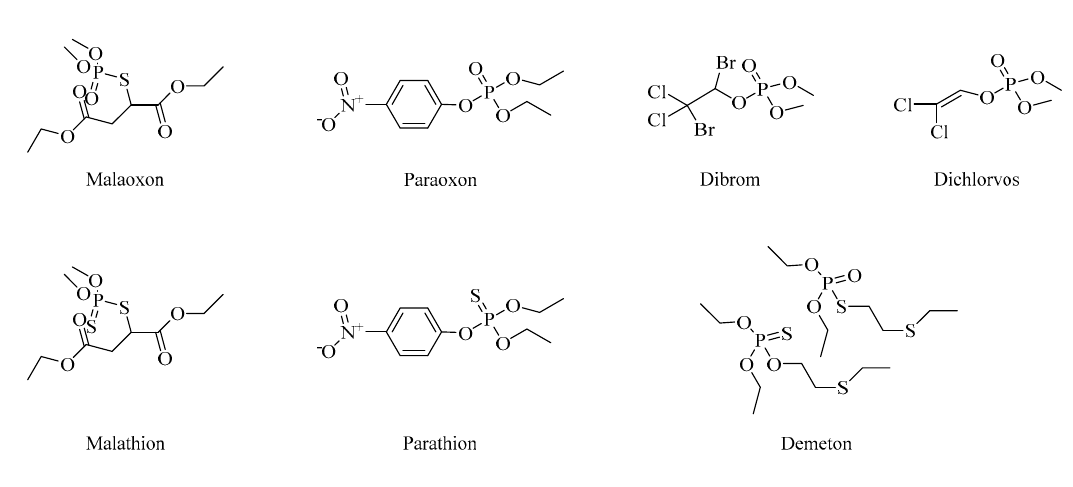
Figure 1. Structures of the studied pesticides.